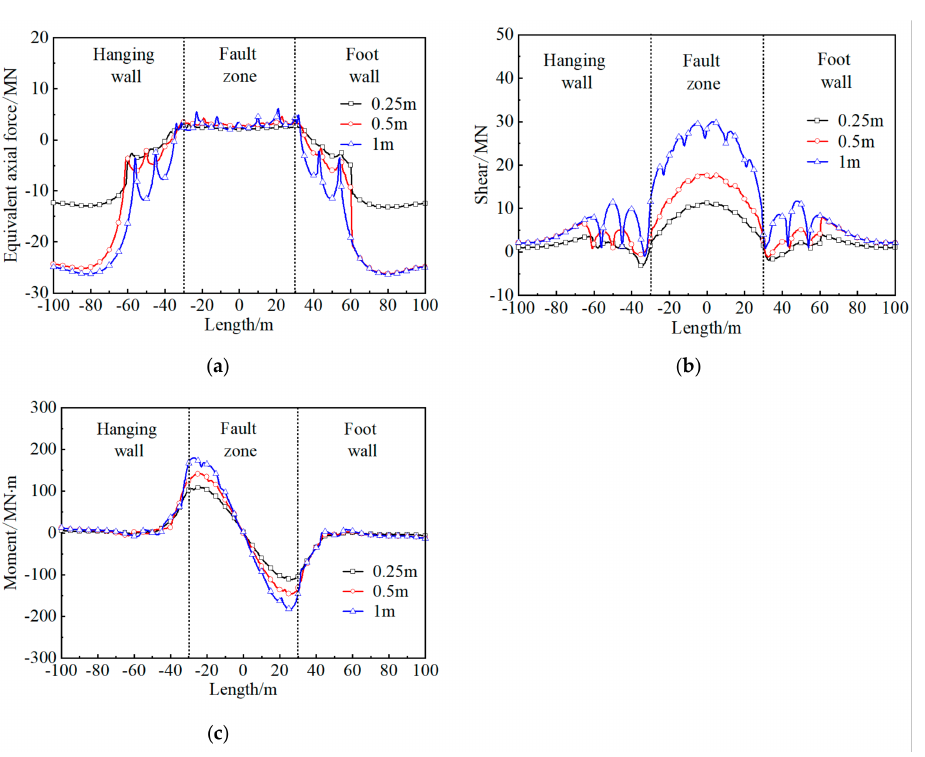
Figure 20. Distribution of internal force and moment for a tunnel under different joint widths. ( a ) equivalent axial force; ( b ) shear; ( c )